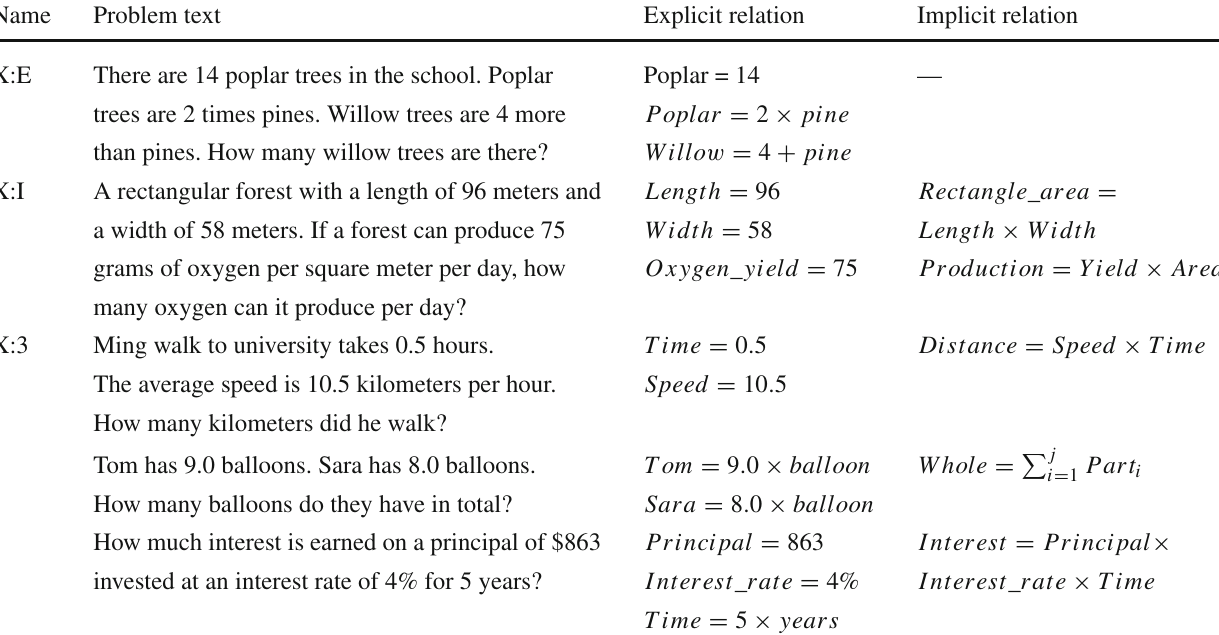
Table 2 The list of sample problems corresponding to the three partial sets X:E, X:I, and X:3